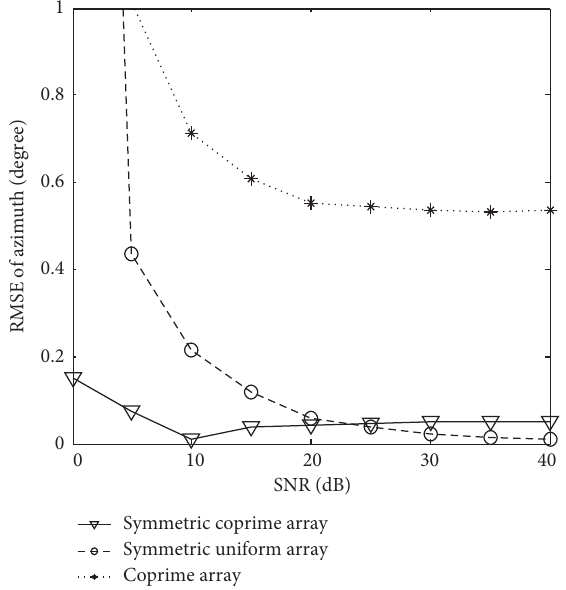
Figure 9: The RMSE of azimuth versus